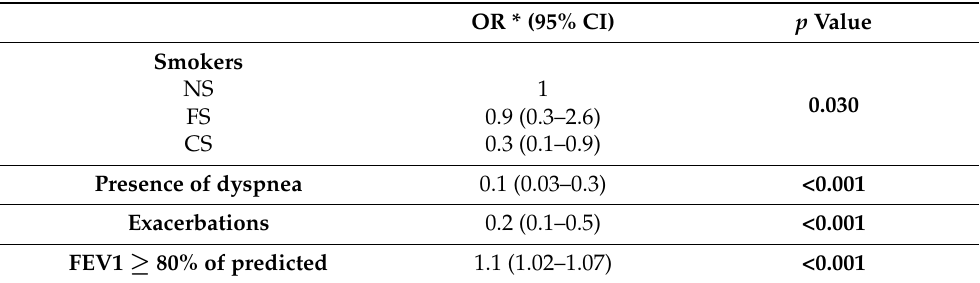
Table 4. Factors associated with asthma control identified by multivariate